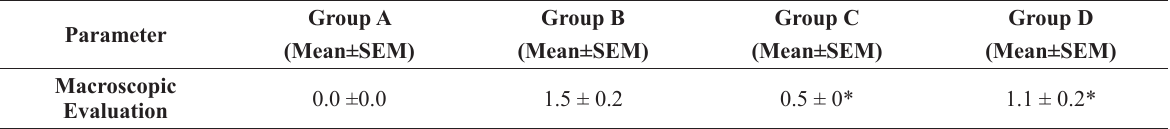
Macroscopic evaluation of the stomach from negative control (group A), positive control (group B), standard drug control (group C) and extract treated group of rats (group D) (* P <0.05; n=5).